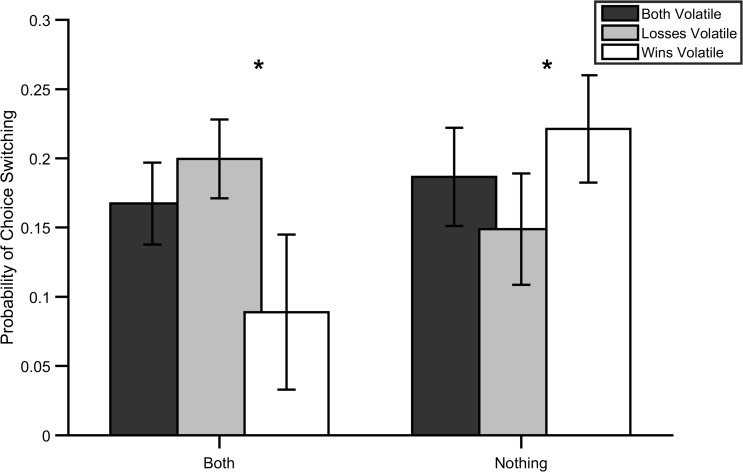
Analysis of switching behaviour in the learning task.The learning task includes both positive and negative outcomes which are independent of each other. As a result the task contains trials in which both positive and negative outcome encourage the same behaviour in future trials (e.g. when the win is associated with shape A and the loss with shape B, both outcomes encourage selection of shape A in the following trial) as well as trials in which the positive and negative outcomes act in opposition (e.g. when both outcomes are associated with shape A, then the win outcome encourages selection of shape A in the next trial and the loss outcome encourages selection of shape B). This second type of trial provides a simple and sensitive means of assessing how the volatility manipulations alters the impact of win and loss outcomes on choice behaviour in the task blocks. Specifically an increased influence of win outcomes (e.g. when wins are volatile) should lead to: (a) A decreased tendency to change (shift) choice when both win and loss outcomes are associated with the chosen shape in the current trial and (b) An increased tendency to change (shift) choice when both win and loss outcomes are associated with the unchosen shape in the current trial. This analysis does not depend on any formal model and thus can be used to complement the model based analysis reported in the main paper. We calculated the proportion of shift trials separately for trials in which both outcomes were associated with the chosen (‘both’) or unchosen (‘nothing’) shape for each of the three blocks (dark columns = both informative; grey columns = losses informative; white columns = wins informative). Consistent with the model based analysis, there was a significant interaction between trial type and block (F(1,28)=10.52, p=0.003). Participants switched significantly less frequently when both outcomes were associated with the chosen option in the win relative to loss informative blocks (F(1,28)=6.1, p=0.02) and switched significantly more frequently when both outcomes were associated with the unchosen option in the win relative to loss informative blocks (F(1,28)=4.69, p=0.04). This indicates that the results reported in the main paper are unlikely to be dependent on the exact form of the behavioural model used to derive the learning rate parameter. Bars represent mean (SEM) probability of switching choice in subsequent trial. *=p < 0.05 for comparison between win informative and loss informative blocks.